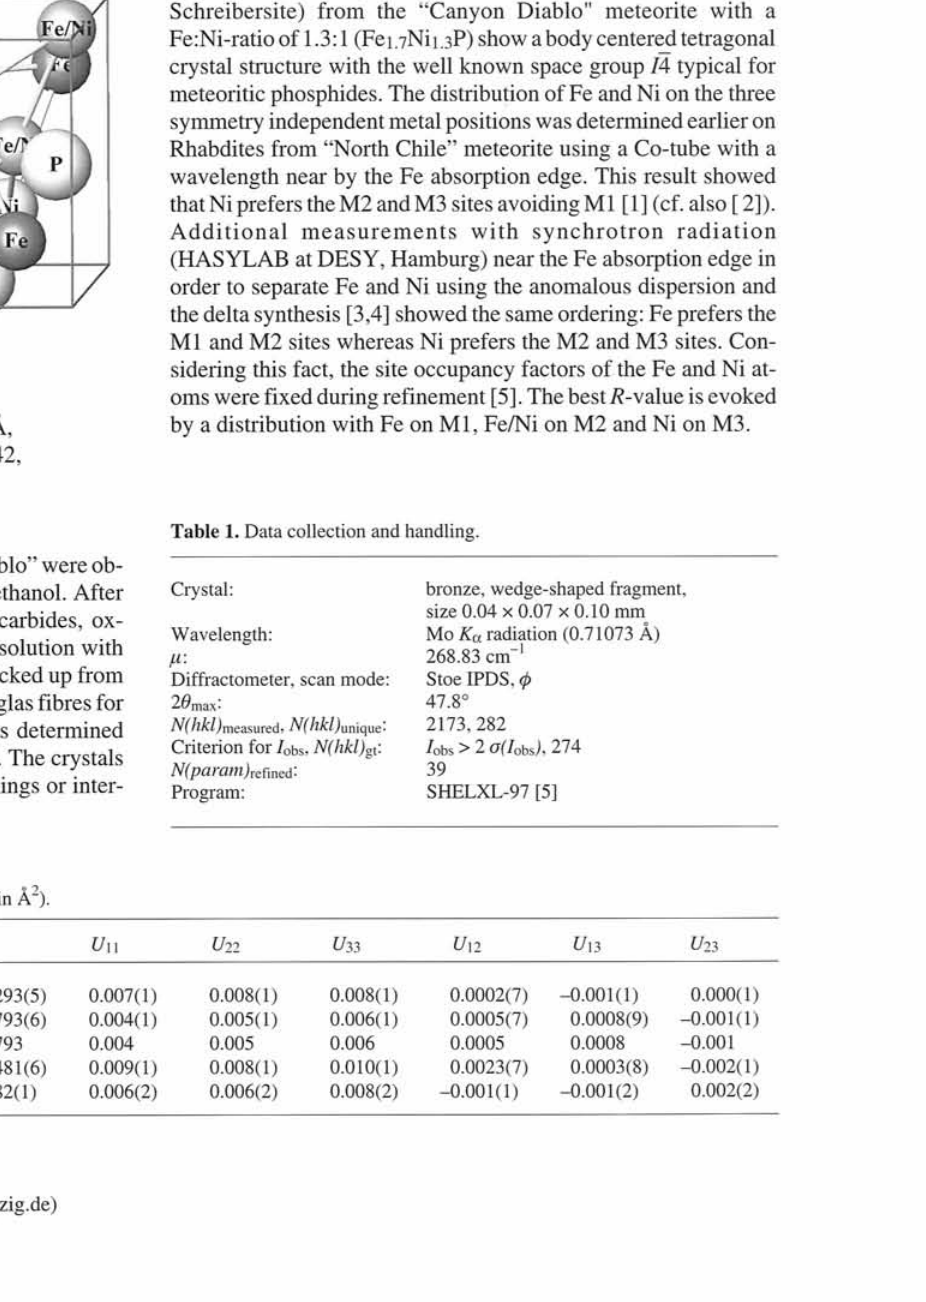
Table 2. Atomic coordinates and displacement parameters (in